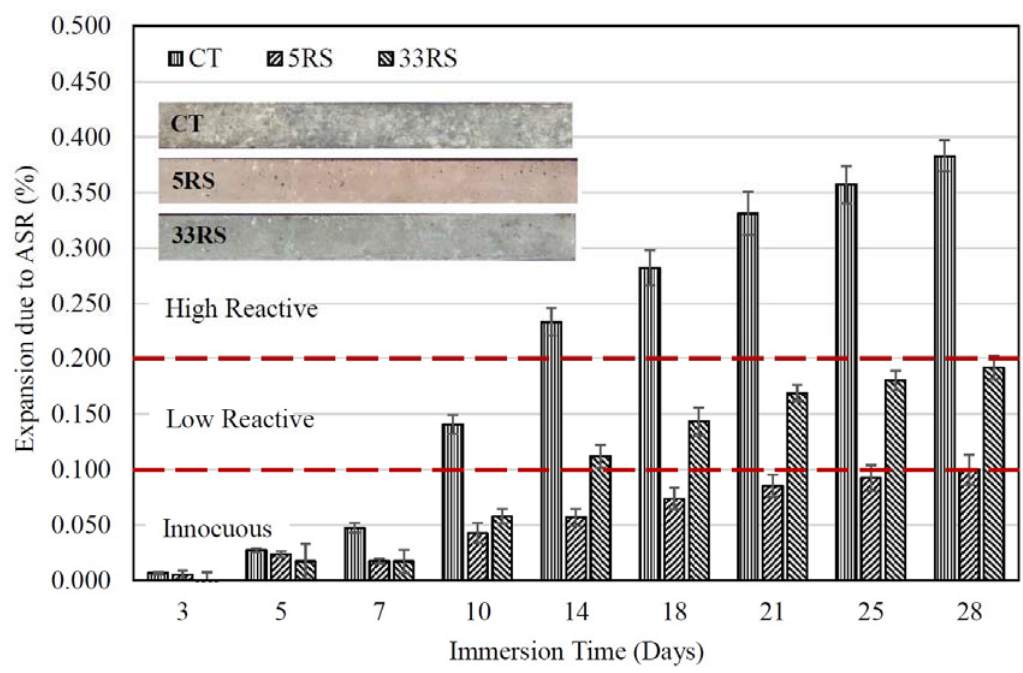
Figure 5. Relationship between the ASR expansion of 5RS and 33RS mortars and immersion time.